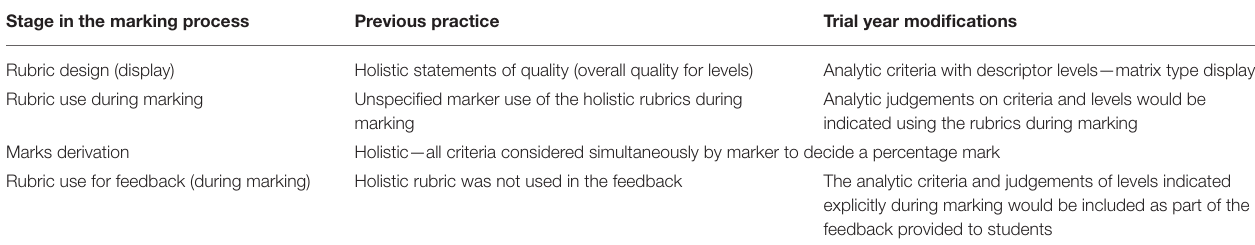
TABLE 2 | Approaches to marking and feedback: traditional and trial